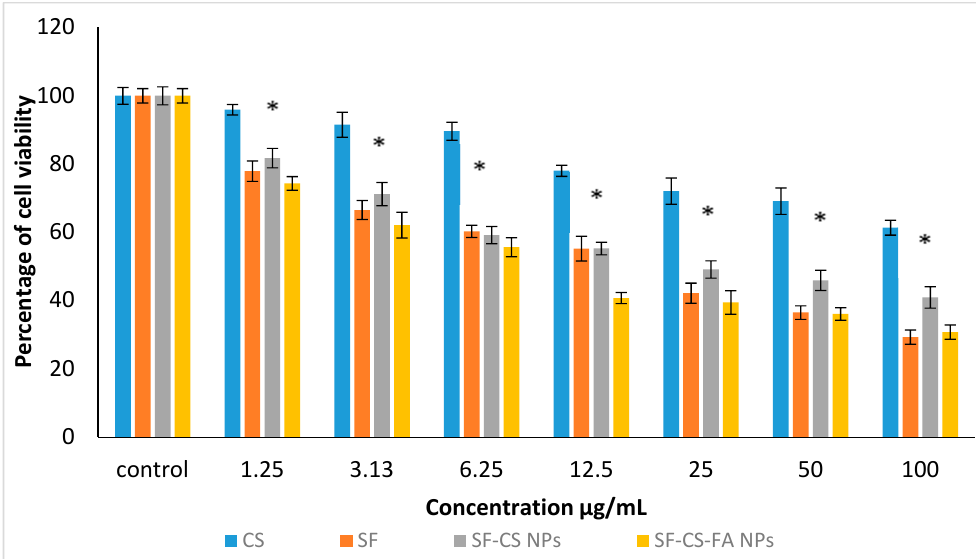
Figure 15. Cytotoxicity assay of CS, SF, SF-CS, and SF-CS-FA nanoparticles against HT29 cells at 72 h of incubation. Values are expressed as mean ± SD of triplicates. The significant differences ( p < 0.05) * were determined among untreated HT29 using the one-way ANOVA followed by Duncan’s Multiple Range Test. Table 6. The half-maximal inhibitory concentration (IC 50 ) value for chitosan (CS), pristine sorafenib (SF), SF-CS, and SF-CS-FA nanoparticles tested on normal HDFa cells, HepG2 and HT29 cell